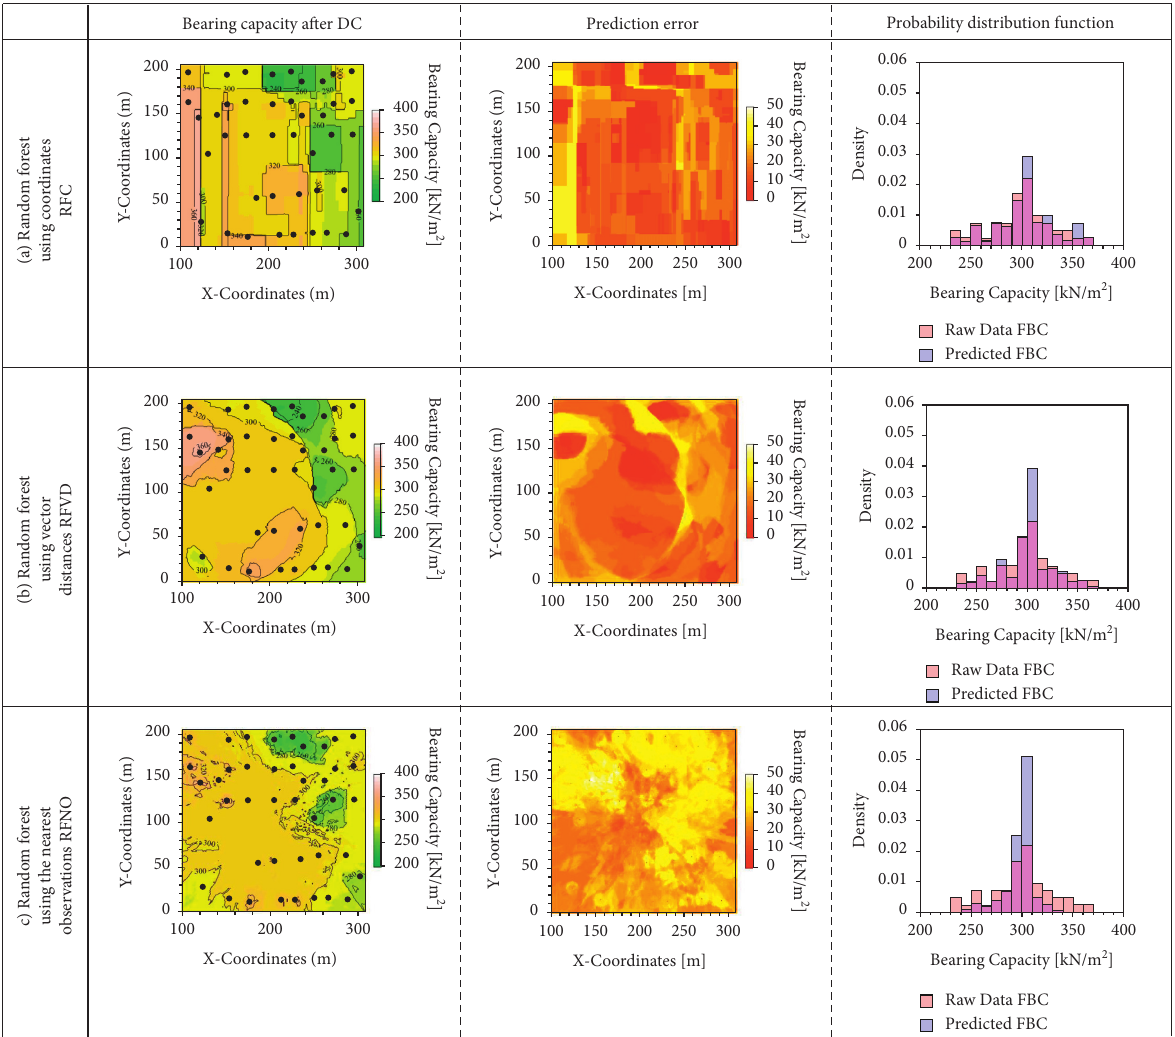
Figure 8: Spatial distribution maps for estimated bearing capacity after DC, prediction error for bearing capacity, and probability dis- tribution function (PDF) for machine learning spatial interpolation models after the dynamic compaction. Results are obtained using (a) random forest using coordinates (RFC), (b) random forest using vector distances (RFVD), and (c) random forest using the nearest observations and their distances (RFNO). Note . The location of the SPT-N boreholes after DC is indicated with black circular